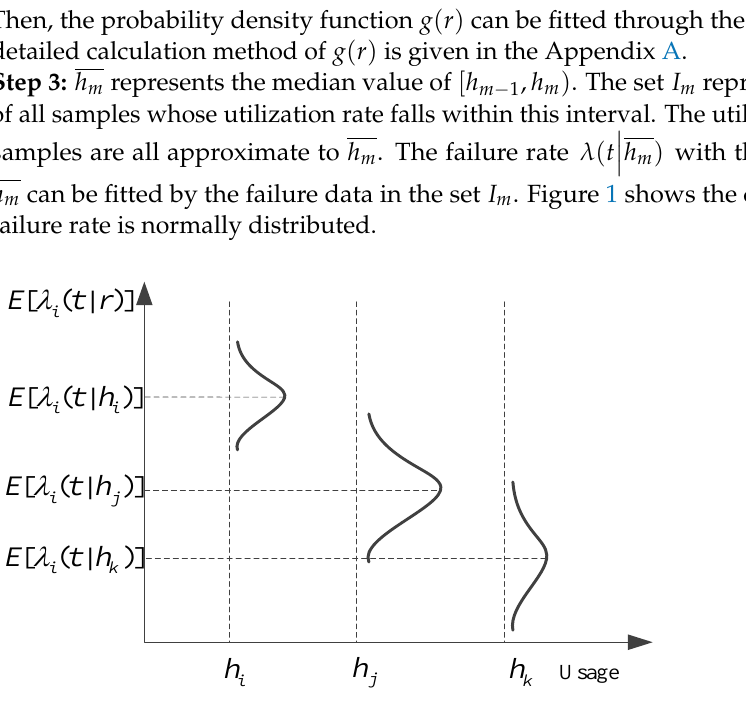
t r  concerning t i